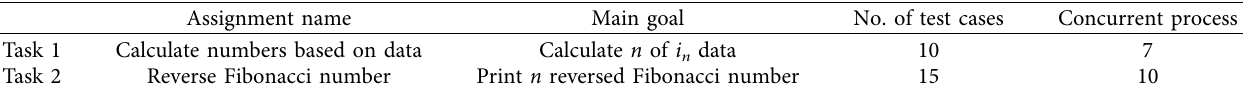
A LGORITHM 3: AST simple tree matching with tag classifier algorithm. Table 4: Experiment setup for testing dynamic